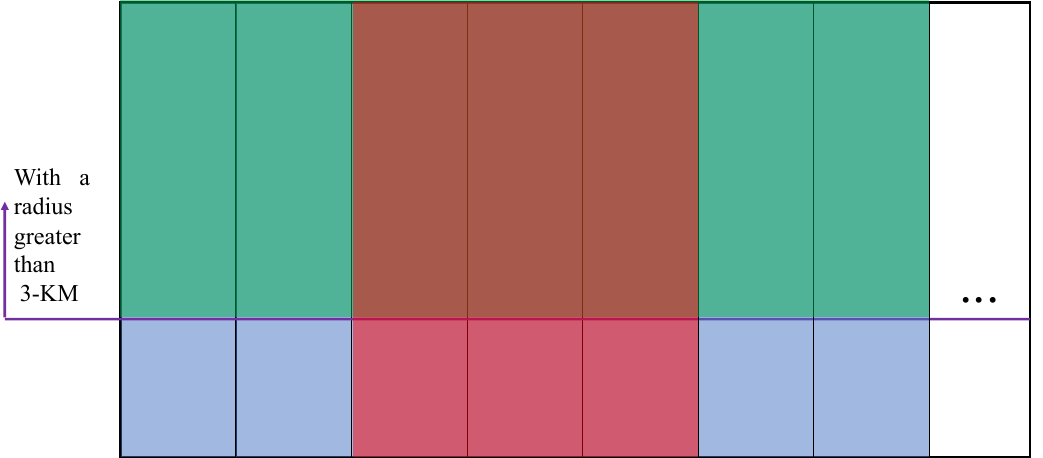
Figure 14. Visualization of the relationship between the existing crater